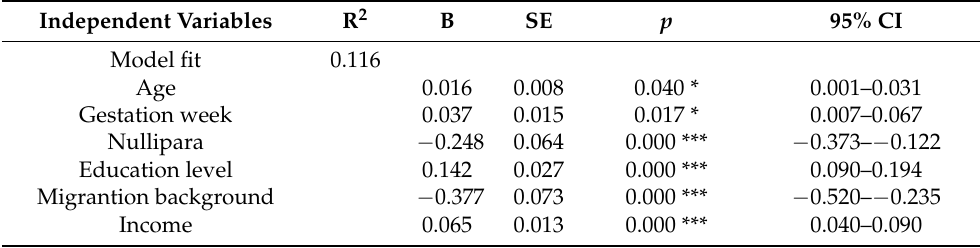
Table 5. Linear regression model (dependent variable = sum score, n = 1191). Independent